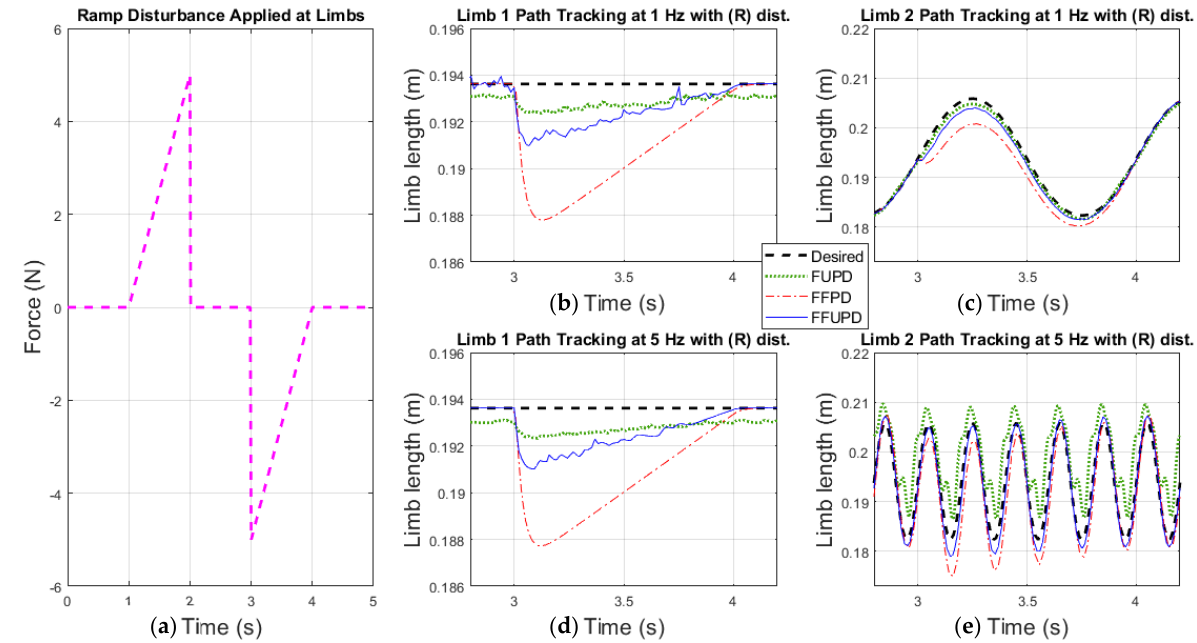
Figure 14. ( a ) Ramp disturbance applied to limbs’ line of action; ( b , d ): limb 1 controlled by FUPD, FFPD and FFUPD during perturbation at 1 and 5 Hz, respectively; ( c , e ): limb 2 behavior at 1 and 5 Hz (respectively) during perturbation.